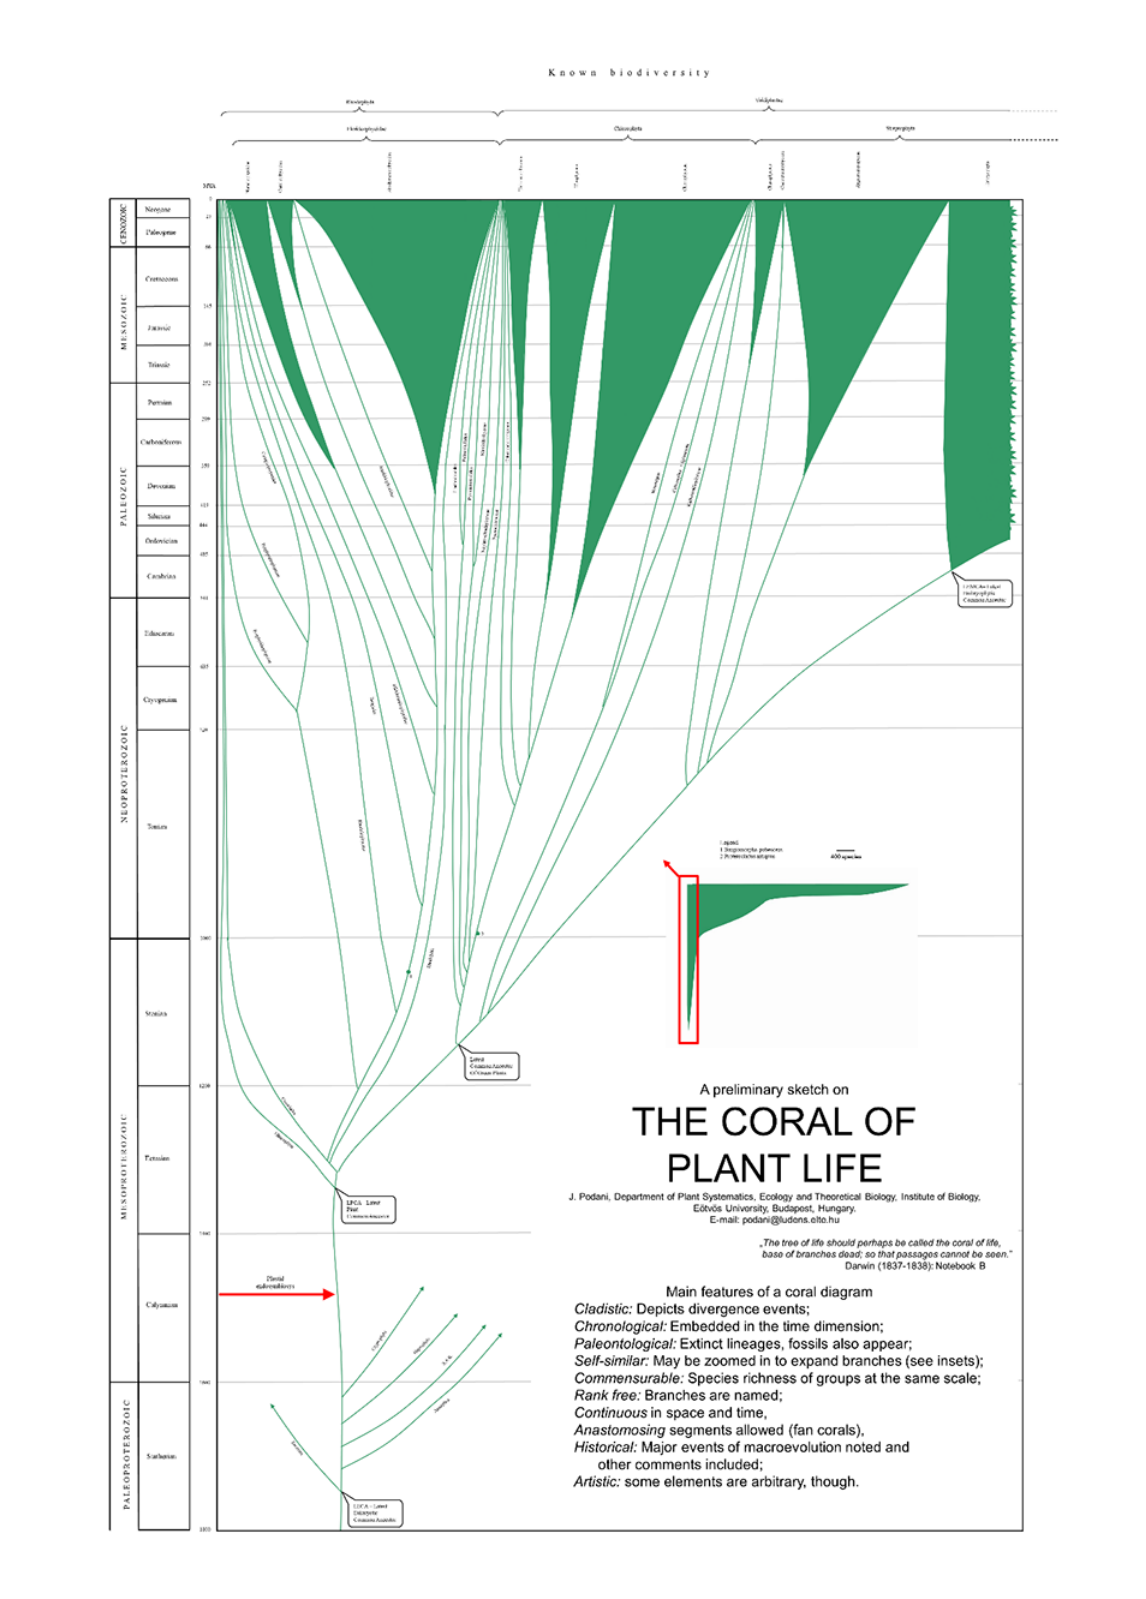
Figure 2 Detail of the Coral of Plant Life, with embryophytes shown in full in Figure 3. High-resolution image is provided as Appendix